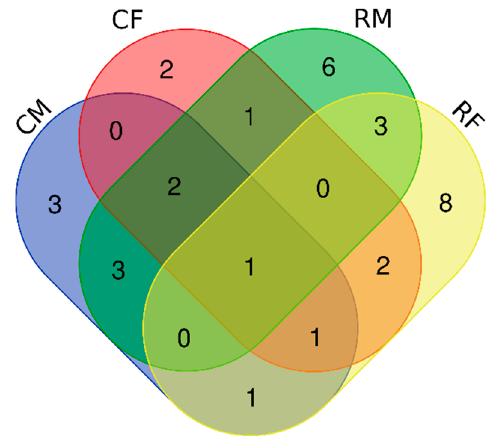
Figure 2. Venn diagram of the whole Pelophylax perezi skin microbial community at genus level. The central part consists in a core group, composed by bacteria belonging to the genera Acinetobacter ; seventeen genera are present only in the reference sites while just five genera are restricted to the contaminated sites. CM, samples from contaminated sites of male frogs; CF, samples from contaminated sites of female frogs; RM, samples from reference sites of male frogs; RF, samples from reference sites of female